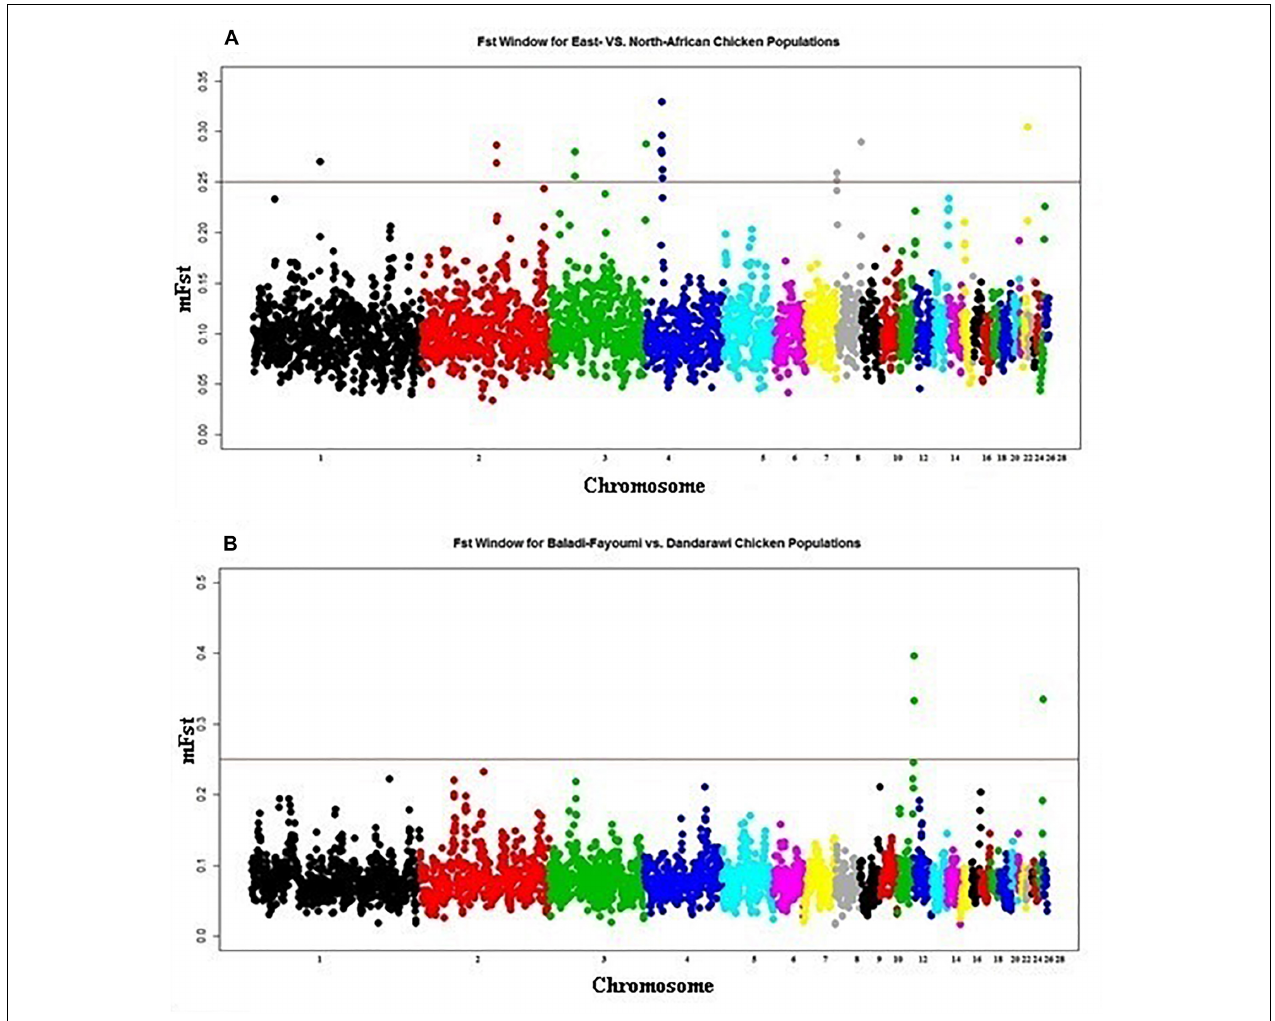
FIGURE 3 | Manhattan plot for the F ST analysis of native African chickens populations showing the pairwise comparison of (A) East-African vs. North-African, and (B) Baladi–Fayoumi vs. Dandarawi populations. Plot is set based on mF ST (mean F ST across overlapping sliding windows). Vertical line presents cut-off threshold of mF ST = 0.25, representing very high genetic